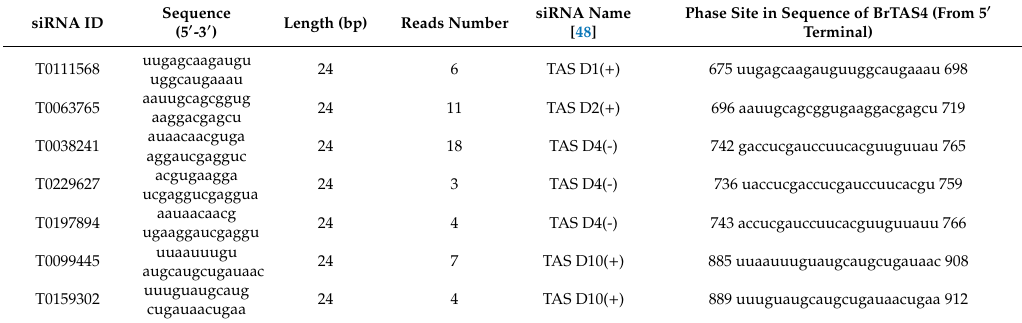
Table 2. The phased tas4 siRNAs identified by high throughput sequencing in UV-A treatment sRNA library of Brassica